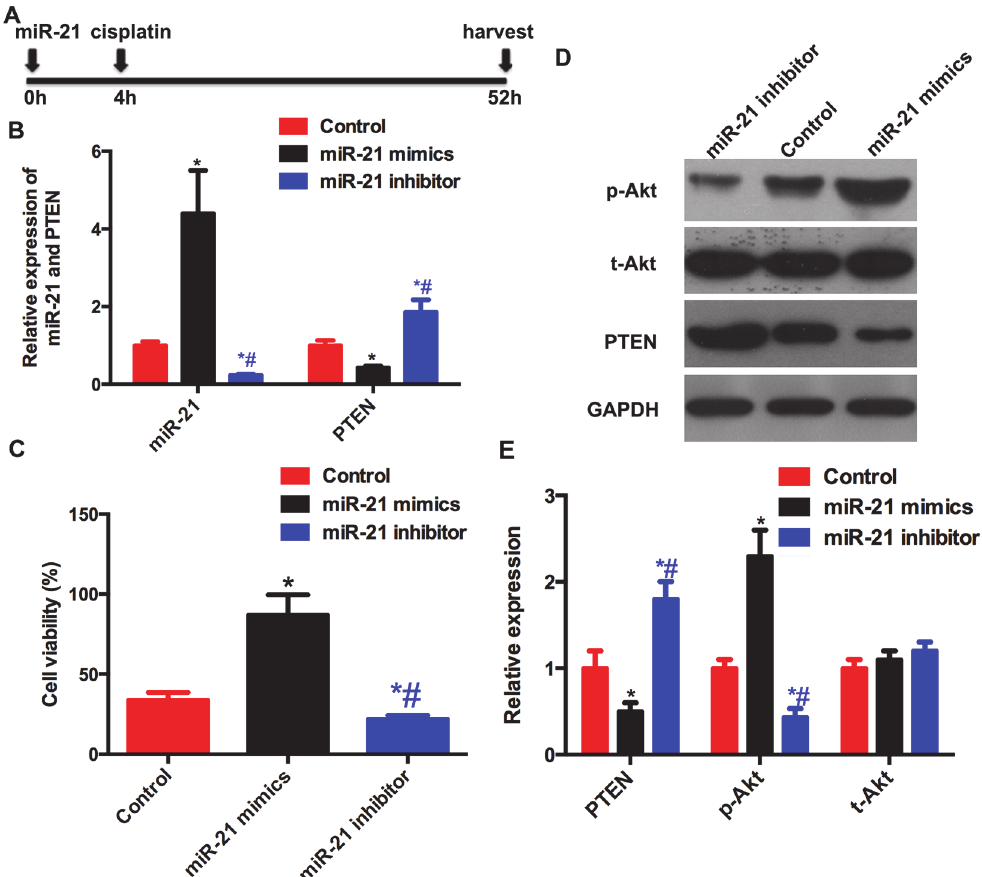
Fig 2. miR-21 modulated PTEN expression and cell viability in A549 cells. The cells in control, miR-21 mimics and miR-21 inhibitor were transfected with 100 nM scrambled oligonucleotide, miR-21 mimic and miR-21 inhibitor, respectively. (A) Time axis of the experiment. The scrambled oligonucleotide, miR-21 mimic or inhibitor was given 4h before cisplatin treatment (5 μ M). And 48h after cisplatin treatment, the cells were harvested for further analysis. (B) The mRNA expression of PTEN was inversely related with miR-21. (C) miR-21 mimics increased the cell viability while miR-21 inhibitor decreased it when cells exposed to cisplatin treatment. (D)Western blotting of PTEN, total Akt (t-Akt) and phosphor ser473 Akt. (E) Graphic representation of PTEN, t-Akt and phosphor-Akt. miR-21 decreased the expression of PTEN and increased the ratio of phosphor-Akt. * compared with control group, # compared with miR-21 mimic group. P < 0.05 as significant